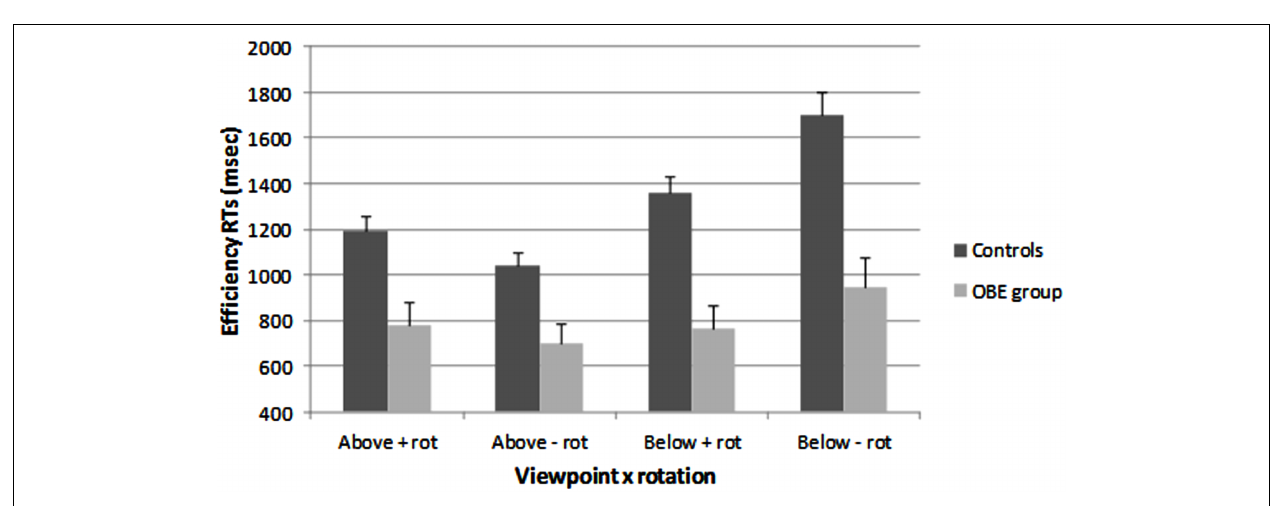
FIGURE 4 | Efficiency RTs for the HOBT task plotted for both Groups (Controls and OBE group) both perspectives (Above and Below) and whether an additional body-rotation was required or not (+ rot = requires body rotation / - rot = does not require body rotation: error bars = 1 SE)